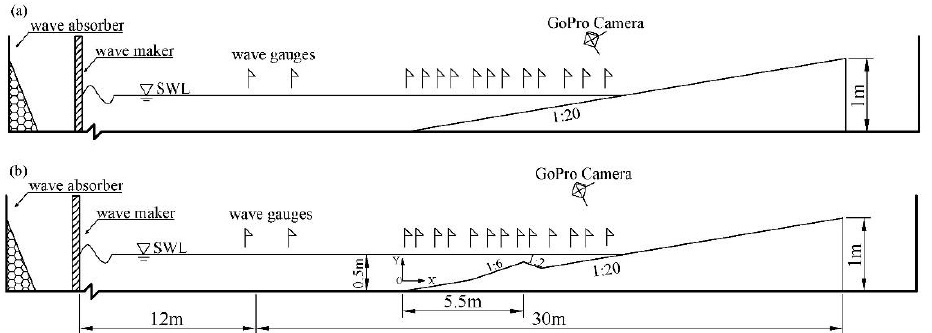
Figure 1. Experimental configuration: The wave flume is equipped with a wavemaker and wave absorber. Wave gauges are fixed on the flume. ( a ) a plane bed. ( b ) a barred bed.